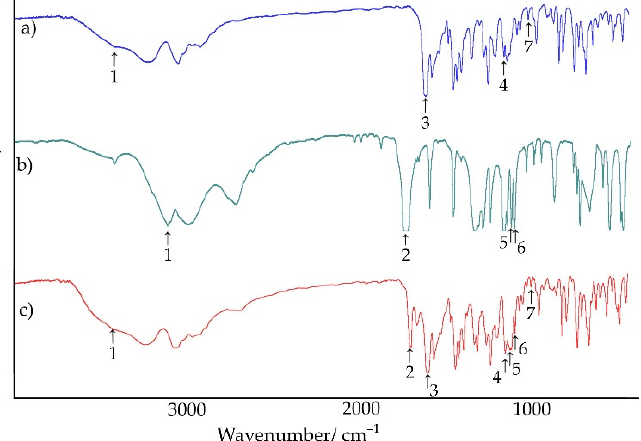
Figure 12. FT-IR spectra for ( a ) chlordiazepoxide, ( b ) saccharin, and ( c ) chlordiazepoxide mixture with saccharin.